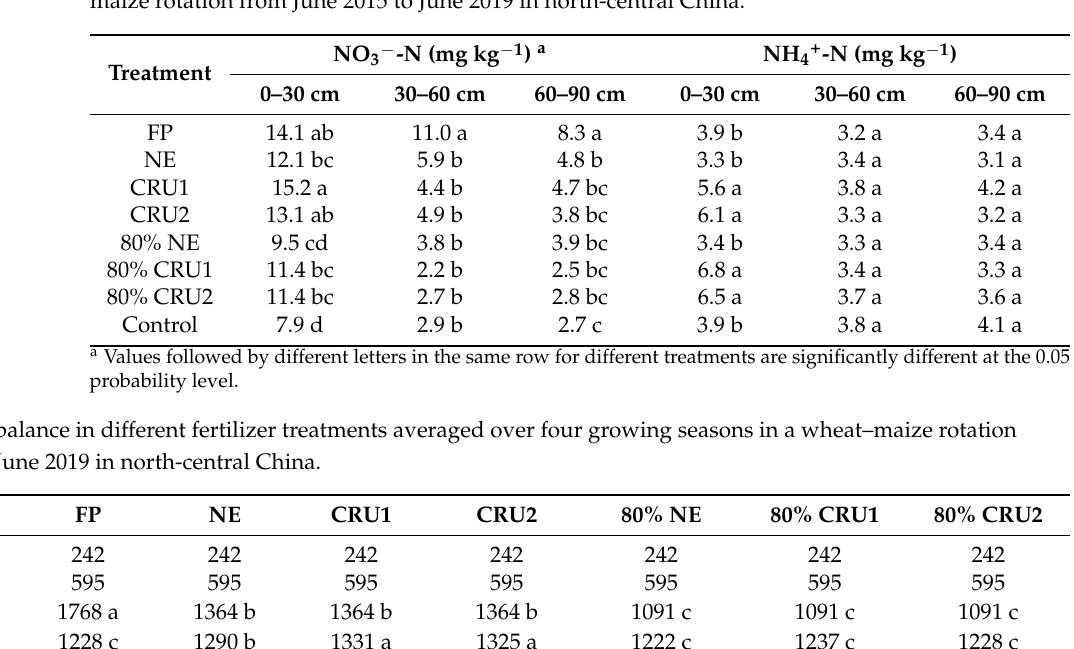
Table 5. Concentrations of soil inorganic nitrogen in three soil layers from 0 to 90 cm in different fertilizer treatments after wheat harvest in June 2019 following four growing seasons in a wheat– maize rotation from June 2015 to June 2019 in north-central China.